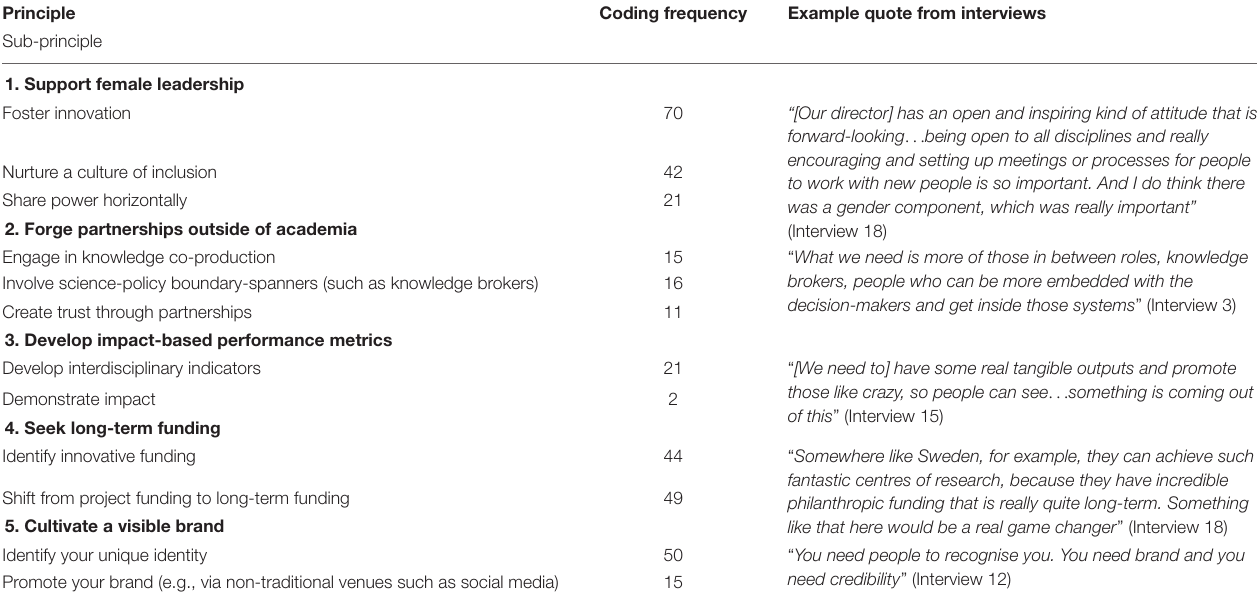
TABLE 1 | Five principles for building effective interdisciplinary research organizations identified through the coding process. Principle Coding frequency